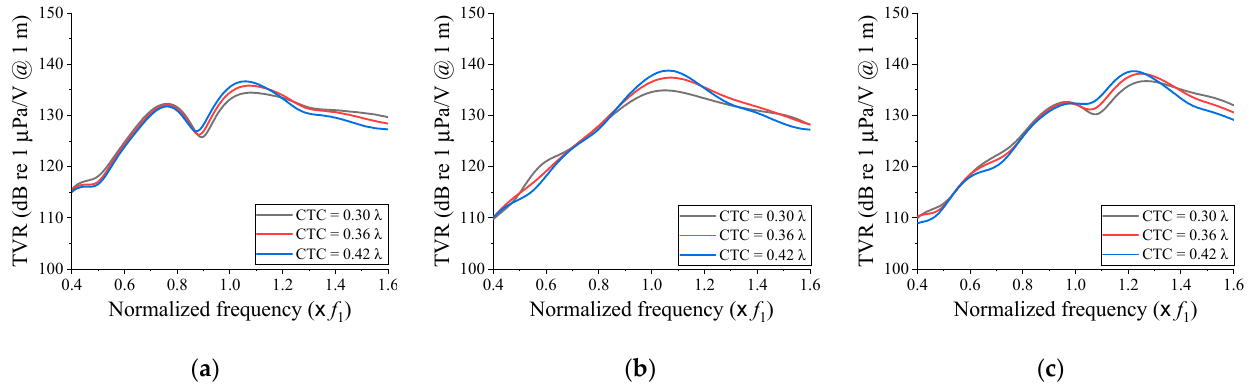
Figure 4. Comparison of the TVR spectra in relation to the center frequency difference and the CTC spacing when the polarity directions of Tx 1 and Tx 2 were the same: ( a ) f 2 = 0.8 f 1 ; ( b ) f 2 = f 1 ; ( c ) f 2 = 1.2 f 1 .